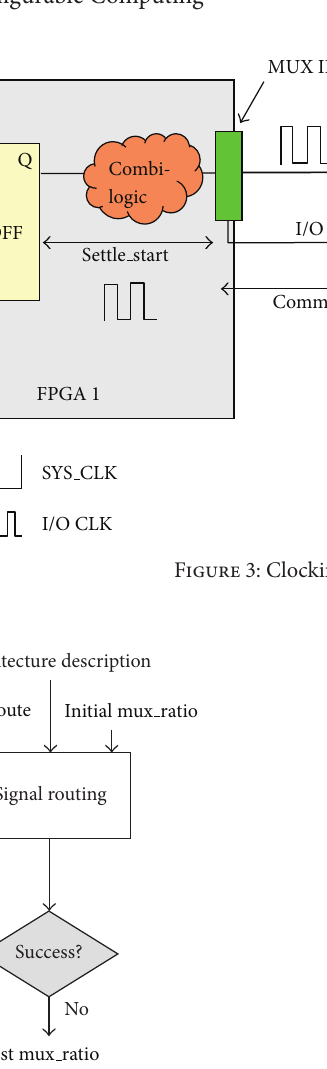
Figure 4: Mux ratio optimization based on iterative